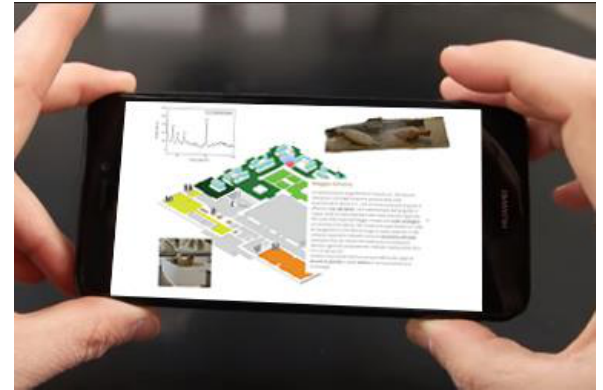
Figure 9. visitor’s position inside the museum’s floor plans, corresponding spectroscopy analysis.